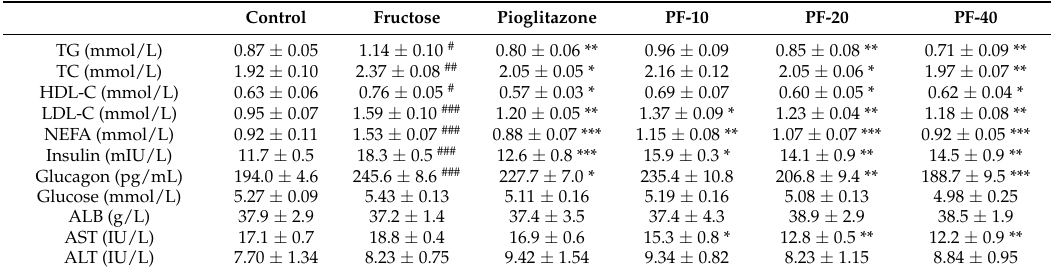
Table 2. Effects of paeoniflorin on the serum biochemical indicators in fructose-fed rats. Control Fructose Pioglitazone PF-10 PF-20 PF-40